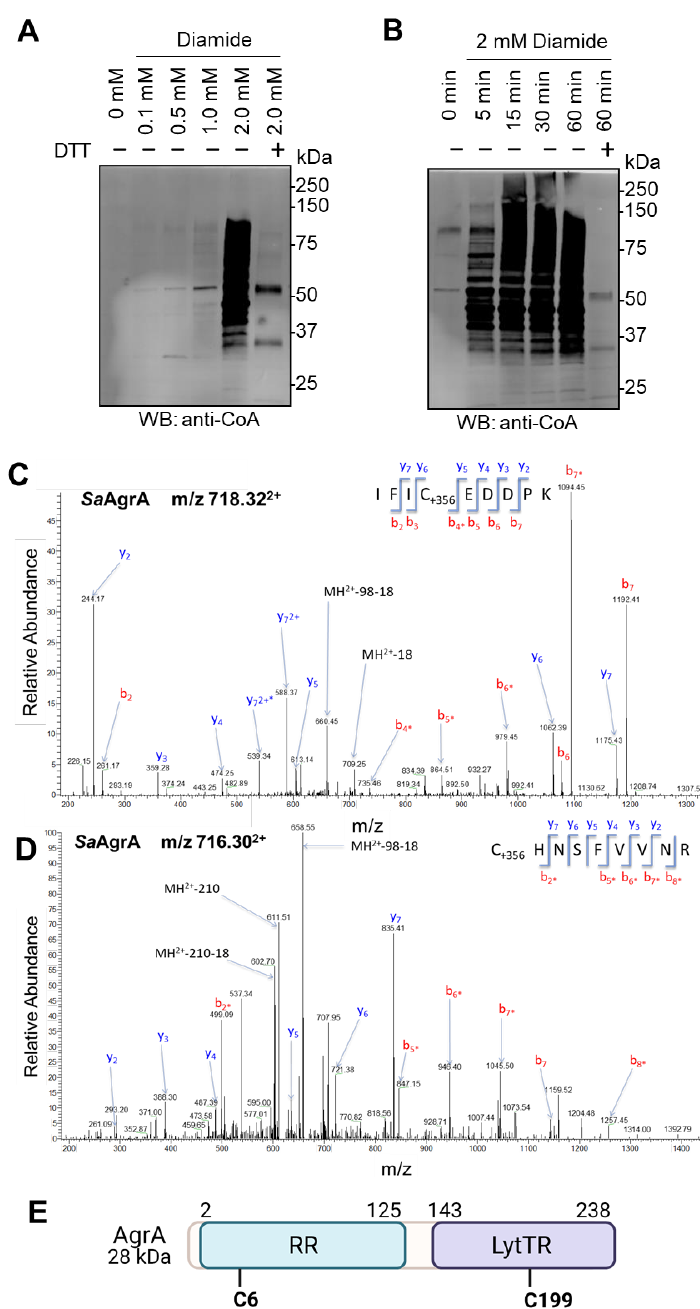
Figure 1. AgrA is CoAlated at Cys6 and Cys199 in diamide-treated S. aureus . ( A ) Anti-CoA Western blot analysis of protein CoAlation in S. aureus in response to a dose-course treatment with diamide. ( B ) Anti-CoA Western blot analysis of protein CoAlation in S. aureus in response to a time-course treatment with diamide (2 mM). To demonstrate that the protein-CoA binding involves a reversible disulfide bond formation, DTT (200 mM final) was added to protein extracts before SDS-PAGE analysis. Figures shown are representative of at least 3 independent repeats. ( C , D ) Mass spectra of CoAlated peptides corresponding to AgrA from the LC–MS/MS analysis of diamide-treated S. aureus cells. Sites of CoAlation were identified as Cys6—ILIC 6 EDDPK ( C ) and Cys199—C 199 HNSFVVNR ( D ) of AgrA. The asterisks (*) denote the loss of phosphoric acid (−98 Da) from the precursor and/or product ions that contained the CoA-modified cysteine residue. ( E ) Schematic diagram of AgrA domain organization with the location of CoA-modified cysteines indicated. RR—response regulatory domain; LytTR—DNA-binding domain. (Created with BioRender.com (accessed on 21 May